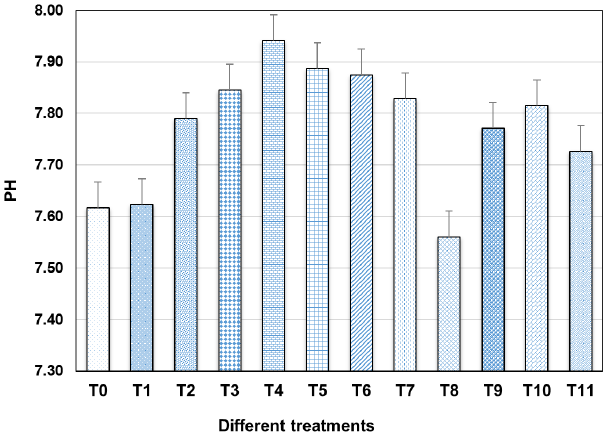
Figure 2. Changes in pH of the soil (average over incubation pe- riods) supplemented with different P sources applied alone or in combination with PSB and PM and incubated at controlled labora- tory conditions at 25 ◦ C. The legend at x axis refers to the differ- ent treatments: T 0 – control; T 1 – RP; T 2 – SSP; T 3 – DAP; T 4 – PM full; T 5 – 1 / 2 RP + 1 / 2 SSP; T 6 – 1 / 2 RP + 1 / 2 DAP; T 7 – 1 / 2